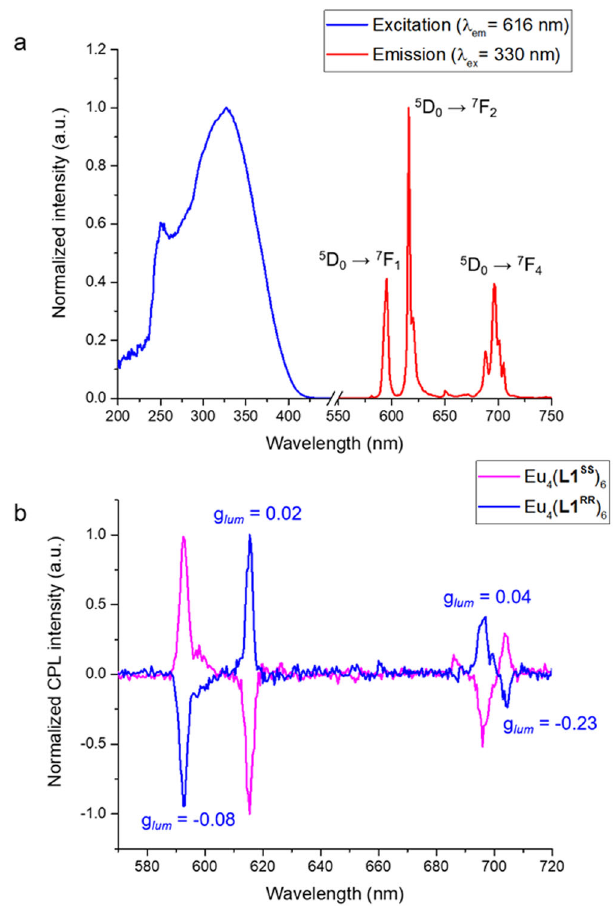
Fig. 7 Photophysical data of Eu 4 L1 RR/SS 6 . a Normalized excitation and emission spectra. Characteristics Eu emission lines were observed which corresponds to the transition from 5 D 0 to 7 F J ( J = 1, 2, and 4). b Normalized CPL spectra of Eu 4 L1 RR/SS 6 in